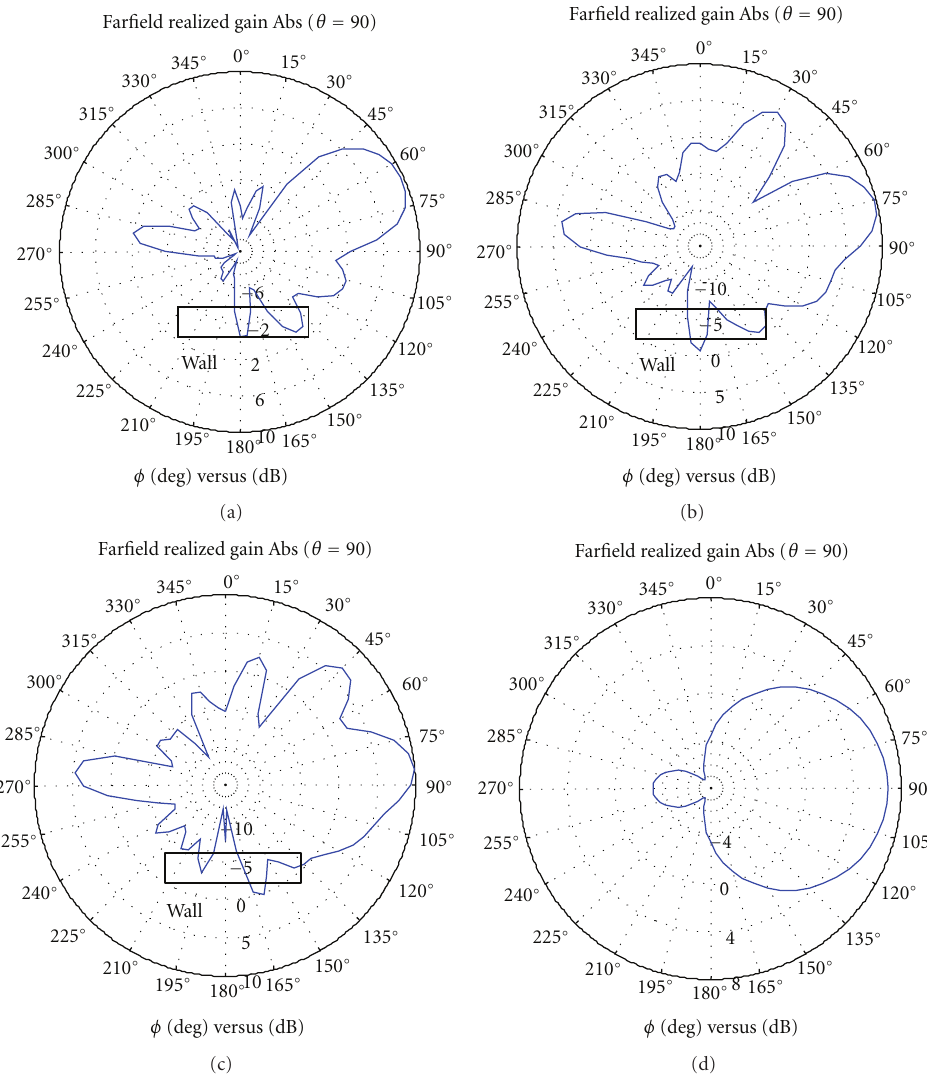
Figure 5: Power gain in azimuth in the perpendicular case (a)–(c) Wall distance 50 mm, 100 mm, and 150 mm; (d) isolated antenna (1.7GHz).